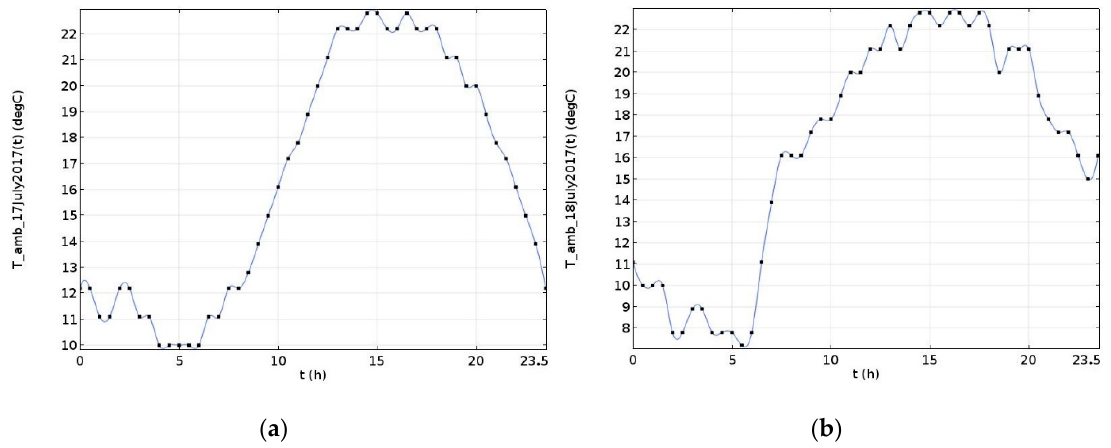
Figure 7. Ambient temperature of: ( a ) 17 July 2017; ( b ) 18 July 2017.